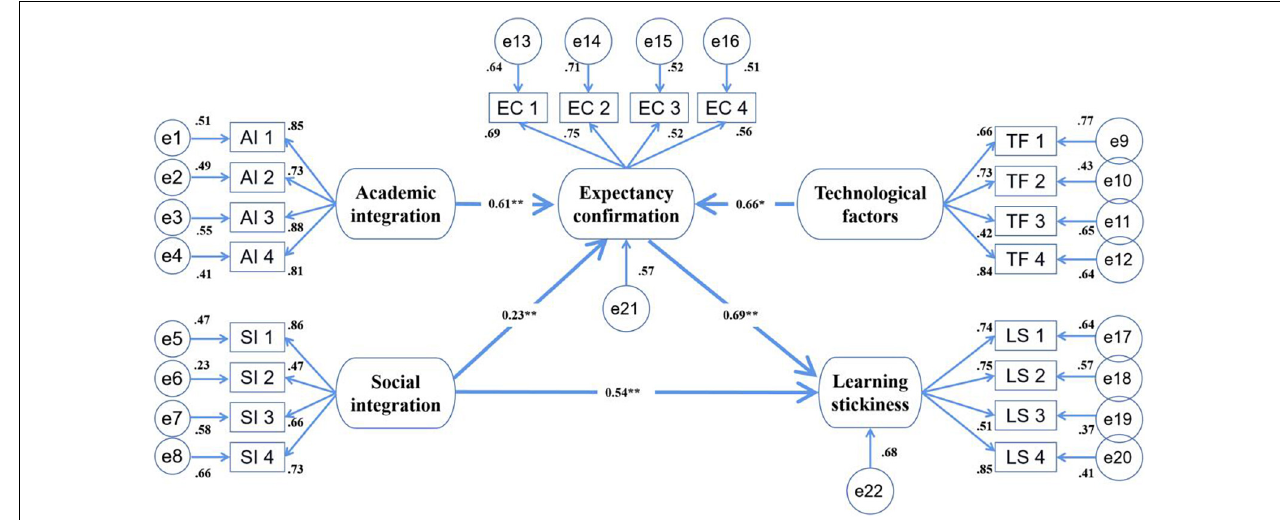
FIGURE 2 | Analysis of the theoretical model. * p < 0.05 and ** p <